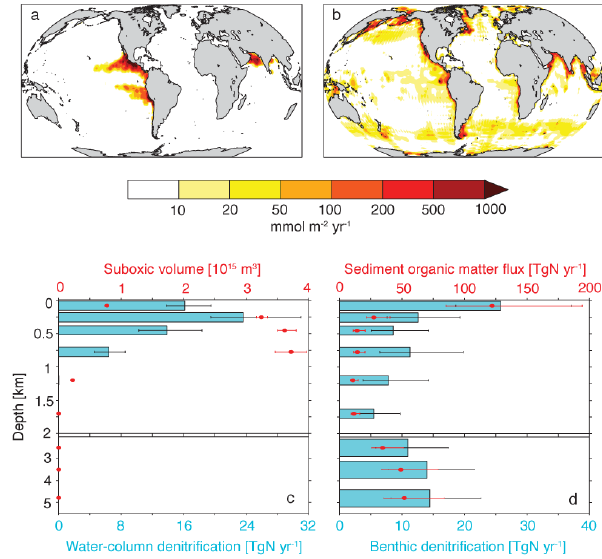
Fig. 4. (a) Depth-integrated rate of water-column denitrification, (b) depth-integrated rate of benthic denitrification, (c) water-column denitrification rate (blue bars with black error bars, lower axis) and suboxic volume (red circles with red error bars, upper axis) in- tegrated over various depth intervals (0–160m, 160–350m, 350– 550m, 550–1000m, 1000–1400m, 1400– 2000m, 2000–3000m, 3000–4000m, and 4000–5500 m) and (d) benthic denitrification Fig. 5. (a) The depth distribution of N ∗ due to benthic denitrification rate (blue bars with black error bars, lower axis) and sediment or- (filled magenta circles with error bars) and water-column denitrifi- ganic matter flux rate (red circles with red error bars, upper axis) Fig. 5. (a) The depth distribution of N ? due to benthic denitrification (filled magenta circles with error bars) and cation (open black circles with error bars). (b) The N:P ratio of integrated over the same depth intervals as in (c) . Note nonlinear water-column denitrification (open black circles with error bars). The N ? due to denitrification is approximated remineralized organic matter calculated according to the method of color scale in (a) and (b) . Vertical axis stretched for top 2000m in by the concentration of an idealized tracer that is lost from the ocean at a rate proportional to the rate of denitri- Anderson and Sarmiento (1994) using the modeled NO 3 and PO 4 (c) and (d) . Median rates are given in (a) and (b) , while error bars fields (red circles with error bars), and the ratio after correcting for in (c) and (d) span the full range of model predictions. fication. (b) The N:P ratio of remineralized organic matter calculated according to the method of Anderson and the amount of NO 3 that is lost due to denitrification (black circles Sarmiento (1994) using the modeled NO 3 and PO 4 fields (red circles and error bars), and the ratio after correct- with error bars). All calculations are performed on isopycnal sur- ing for the amount of NO 3 that is lost due to denitrification (black circles with error bars). All calculations are faces and plotted at the mean depth of each performed on isopycnal surfaces and plotted at the mean depth of each isopycnal.